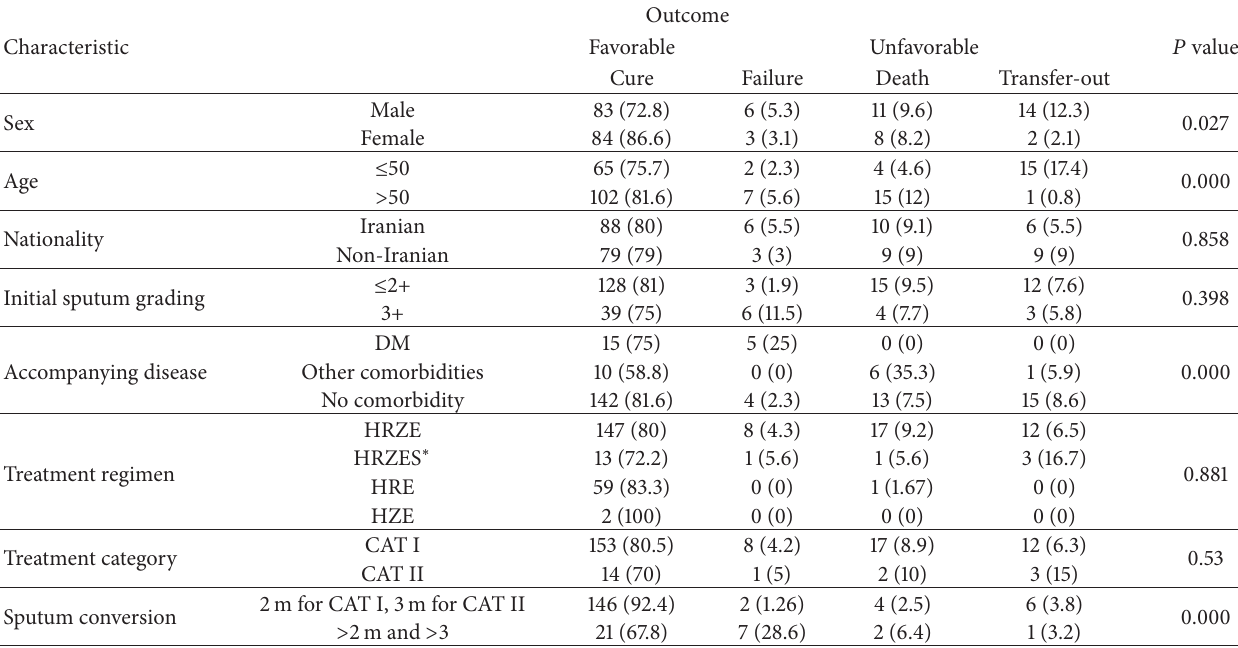
Table 3: Impact of comorbidities and demographic, microbiological, and therapeutic variables on outcome of patients ( 𝑁 = 211